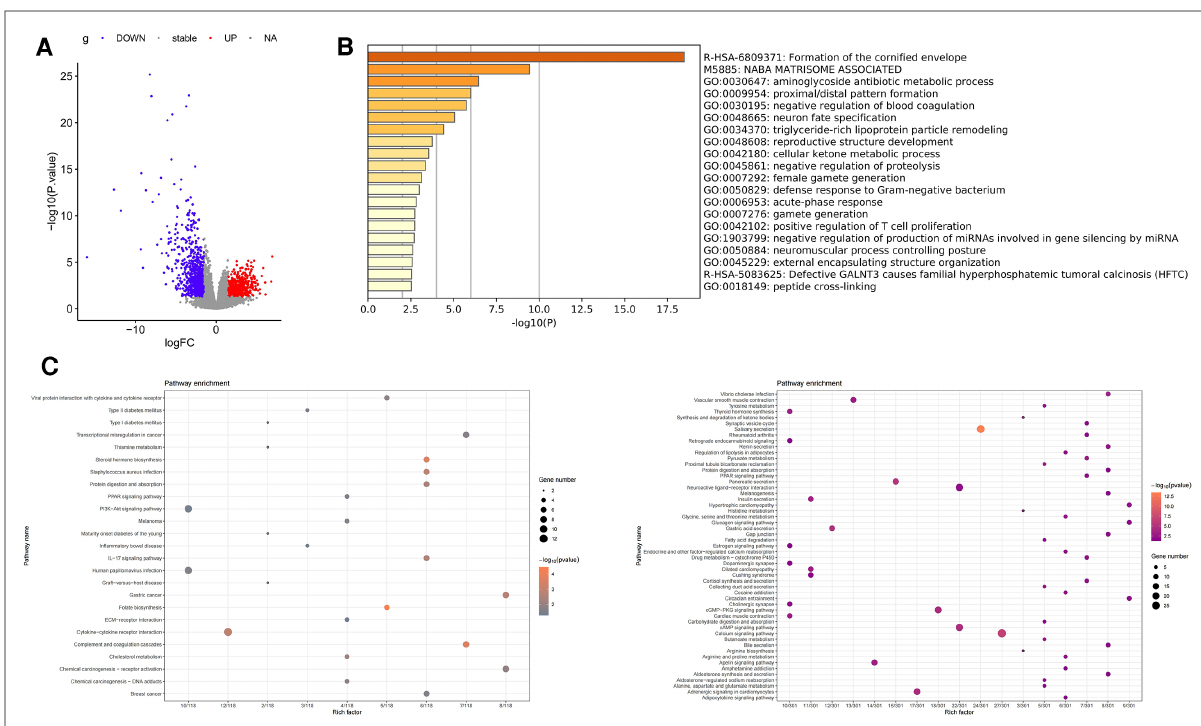
FIGURE 3 Differential expression analysis of TSCC in the TCGA database. ( A ) Volcano map representing DEGs of TSCC in the TCGA database, with red representing upregulated genes and blue representing downregulated DEGs. ( B ) Results of pathway enrichment analysis of upregulated differentially expressed genes using Metascape. ( C ) Pathway enrichment analysis of DEGs; the left represents the enrichment of the upregulated gene KEGG pathway, and the right represents the enrichment of the downregulated gene KEGG